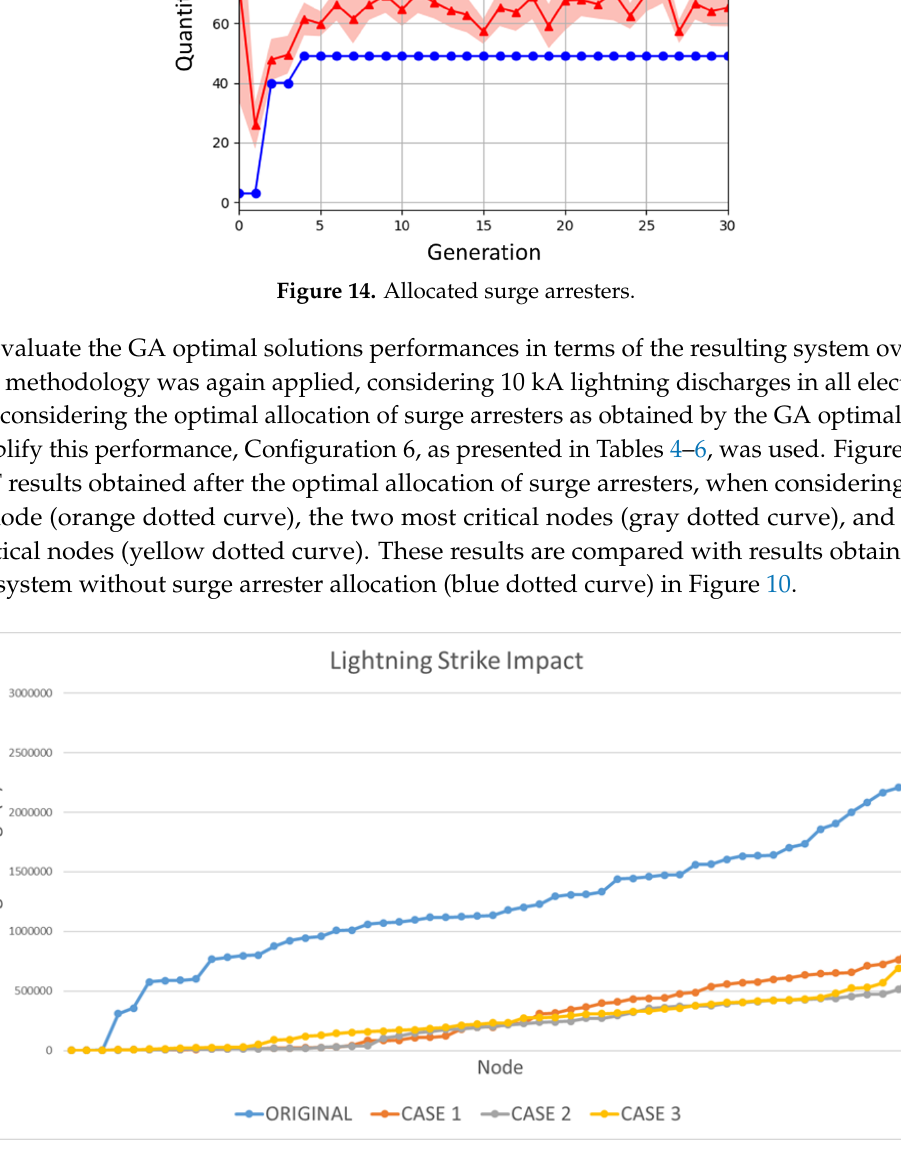
Figure 15. Graphical representation of CMT results before and after surge arresters